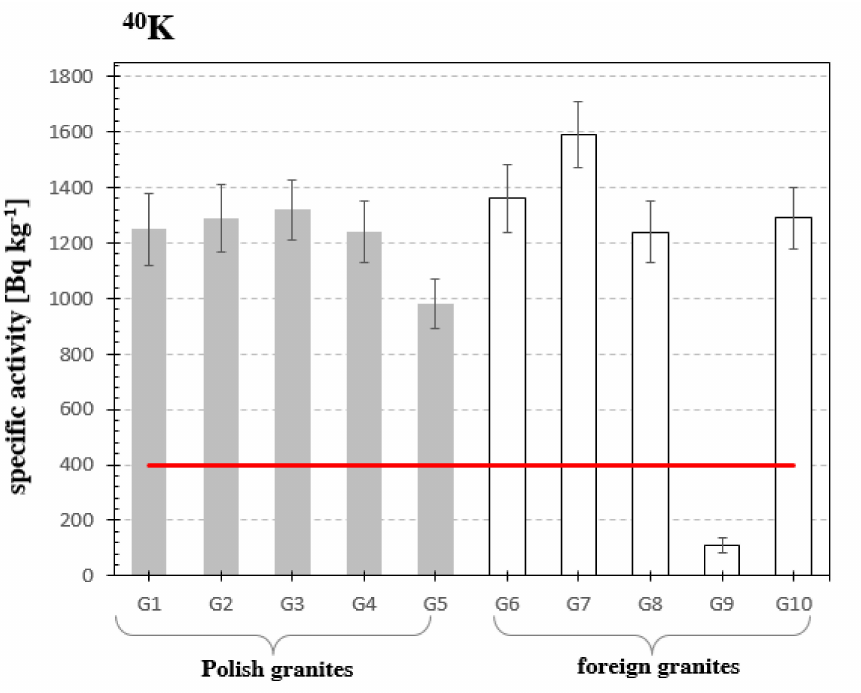
Figure 3. Specific activity of potassium 40 K in analyzed samples of granites. The horizontal line indicates the average specific activity of 40 K of building materials recommended by the European Commission in the Report [25] of 400 Bq · kg − 1